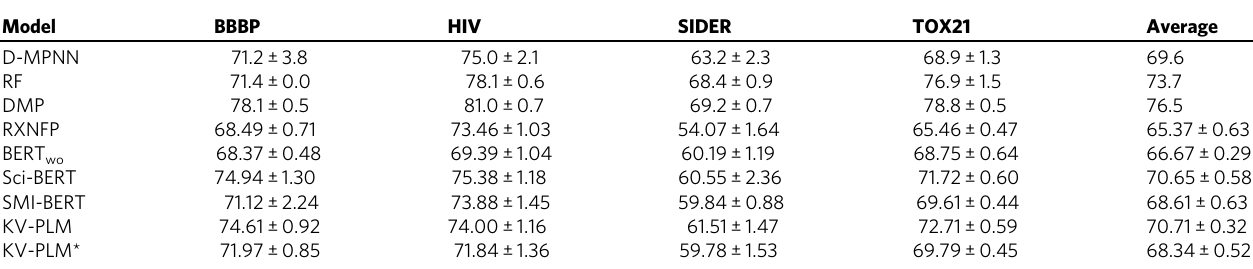
Table 3 Experiment results on 4 MoleculeNet themes. Baseline results are cited from ref. 50 .